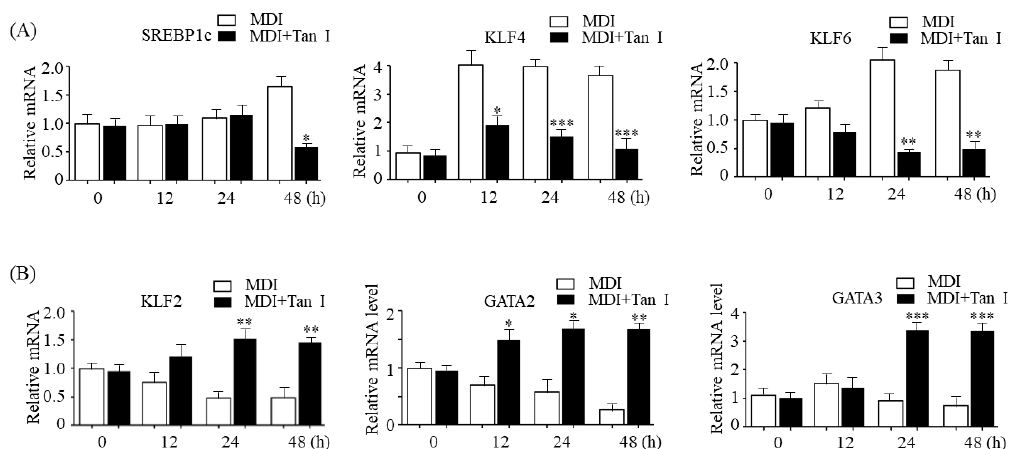
Figure 7. Tan I regulated expression of early adipogenic transcription factors during early adipogenesis. The 3T3-L1 preadipocytes were differentiated in the MDI with 10 μ M Tan I for indicated times. ( A ) mRNA levels of early adipogenic activators including SREBP1c , KLF4, and KLF6 were determined by qPCR. ( B ) mRNA levels of early adipogenic repressors including KLF2 , GATA2, and GATA3 were determined by qPCR. The data are presented as the mean ± SEM of three replicate experiments. * p < 0.05, ** p < 0.01, *** p < 0.001 vs. 3T3-L1 adipocytes without Tan I treatment at indicated time.